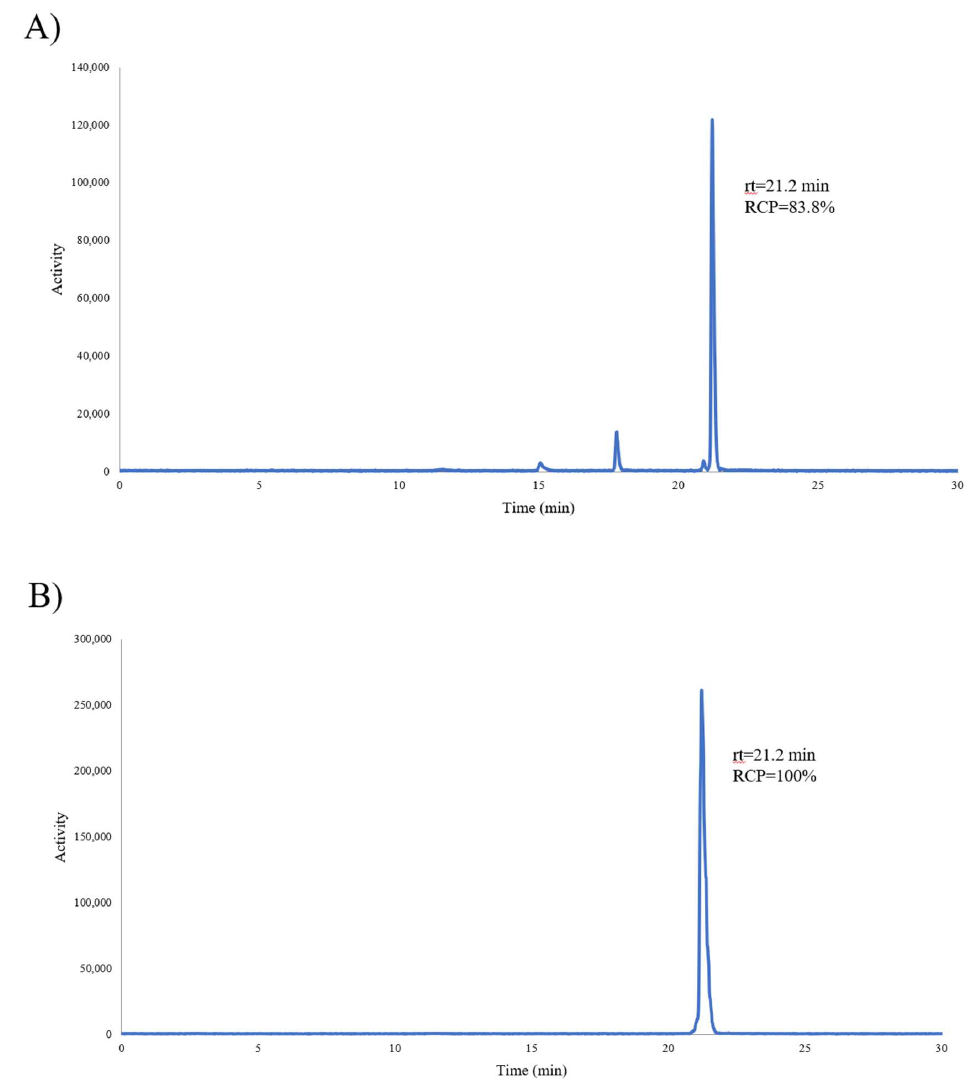
Figure 2. Typical HPLC profile of the radiolabeling corresponding to C1 ( A ) before and ( B ) after HPLC purification. HPLC